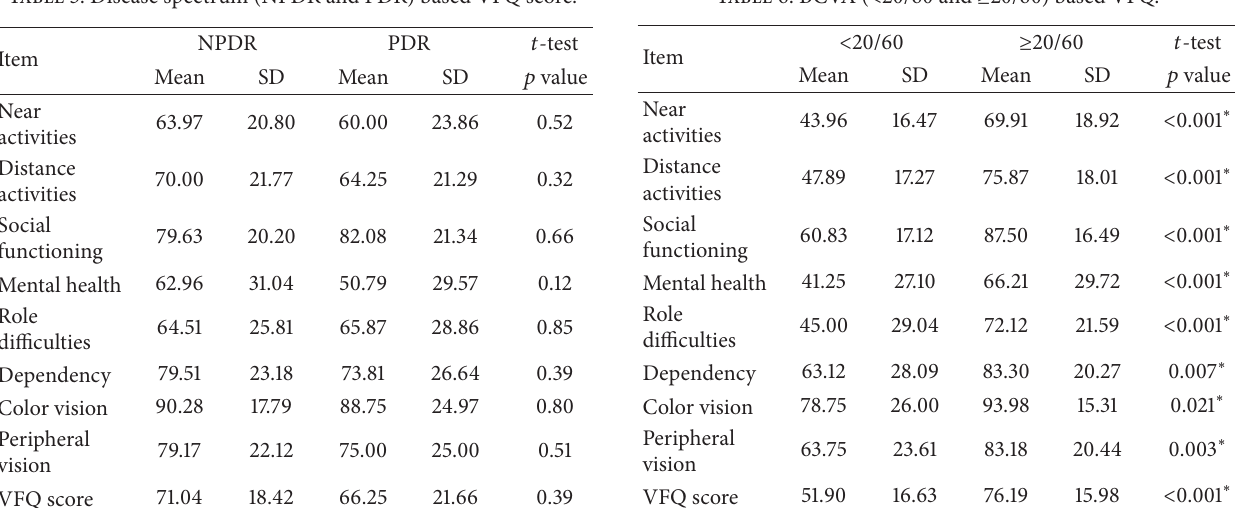
Table 5: Disease spectrum (NPDR and PDR) based VFQ score. Table 6: BCVA ( < 20/60 and ≥ 20/60) based